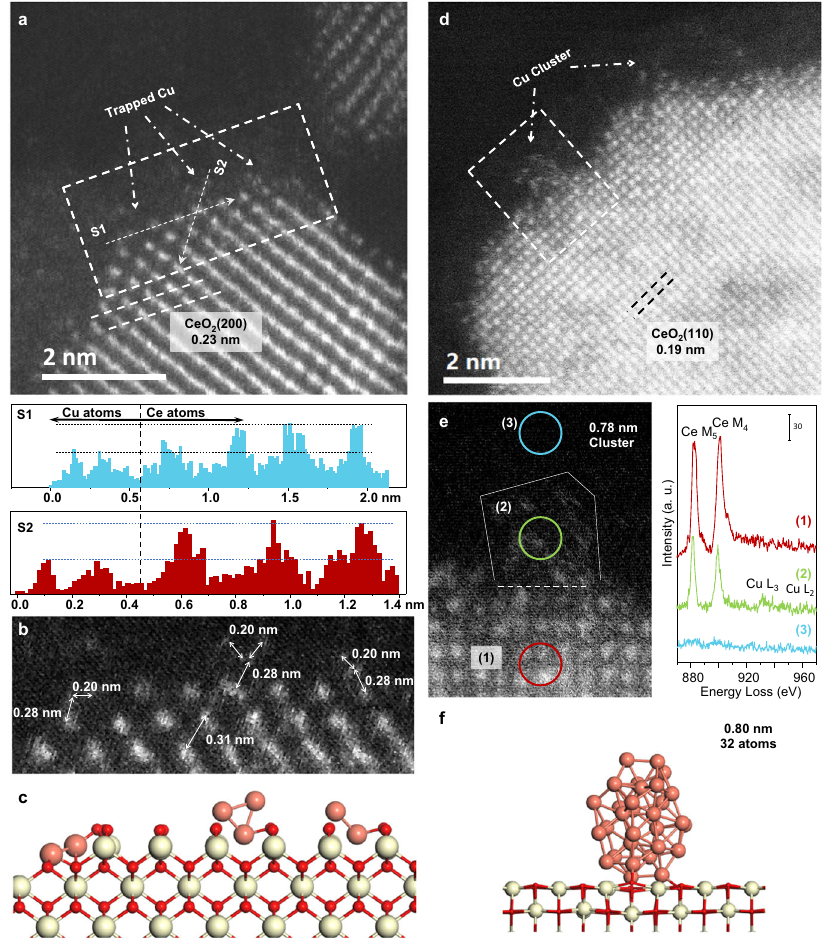
Fig. 3 | Structural information of Cu clusters in 5Cu-Stable and 7Cu-Stable. a HAADF-STEMimageof5Cu-Stableandintensitylinescansfromtwodirections(S1 and S2) of the top atomic layers of CeO 2 . The top three layers of CeO 2 edge (8×3 atoms) surface was magni fi ed as shown in ( b ). b Distance between atoms. The distance between the darker atoms and the brighter atoms are 0.20nm and 0.31nm respectively, corresponding to the interatomic distance of Cu-Cu and Ce-